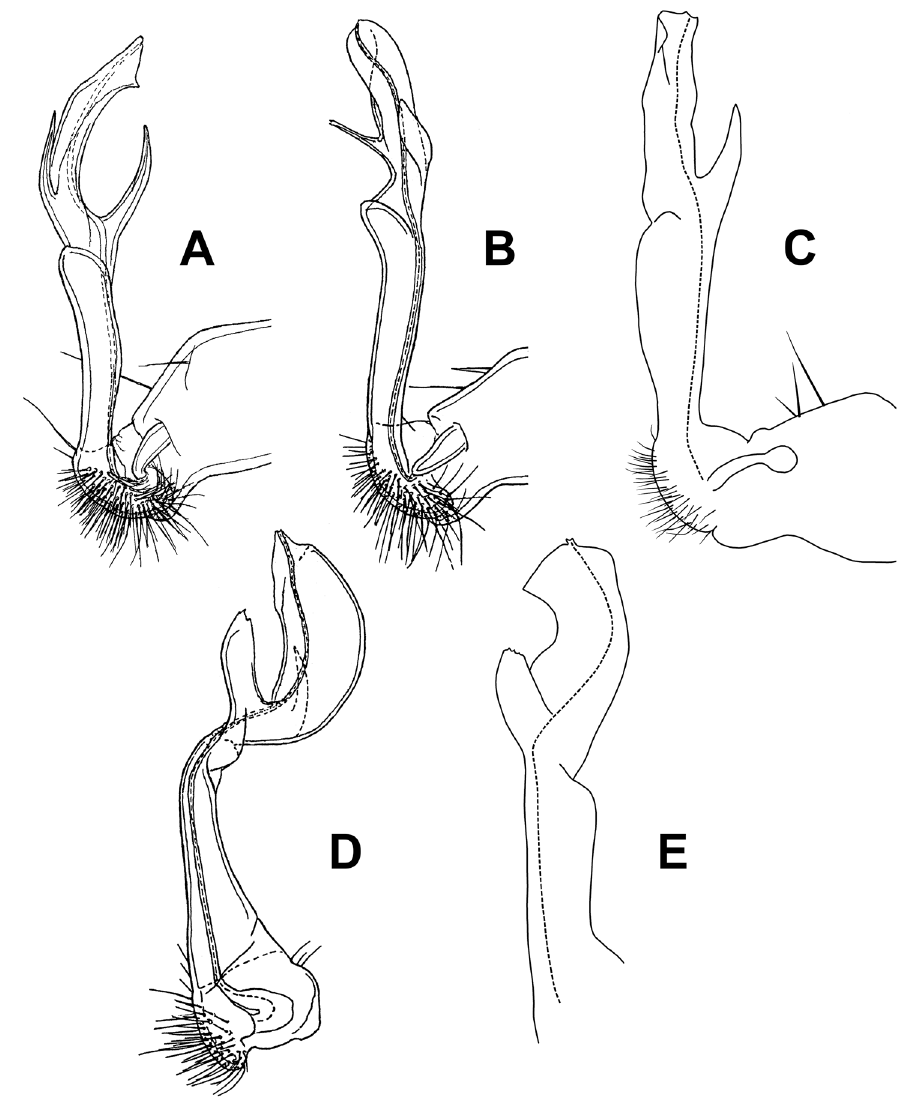
Figure 5. Gonopods of Tridactylogonus species. A T. obscurus holotype (after Jeekel 1982) B, D T. rugosissimus holotype (after Jeekel 2002) C, E T. warrenbenensis sp. n. paratype (ex SAM OM2185- OM2194) A–C medial views of right gonopod D, E anterior and anterior and slightly medial views, respectively D originally of left gonopod telopodite, here right-left reversed for comparison with right gonopod in E . Dashed line in C and E marks the prostatic groove. Drawings not to scale. prozonites were said to have either “pronounced reticulate structure or minute and regu- lar granulation”, while the metatergites were “coarsely and densely rugose, with irregular longitudinal or somewhat oblique or undulate rugae”, and the sides “coarsely granulose